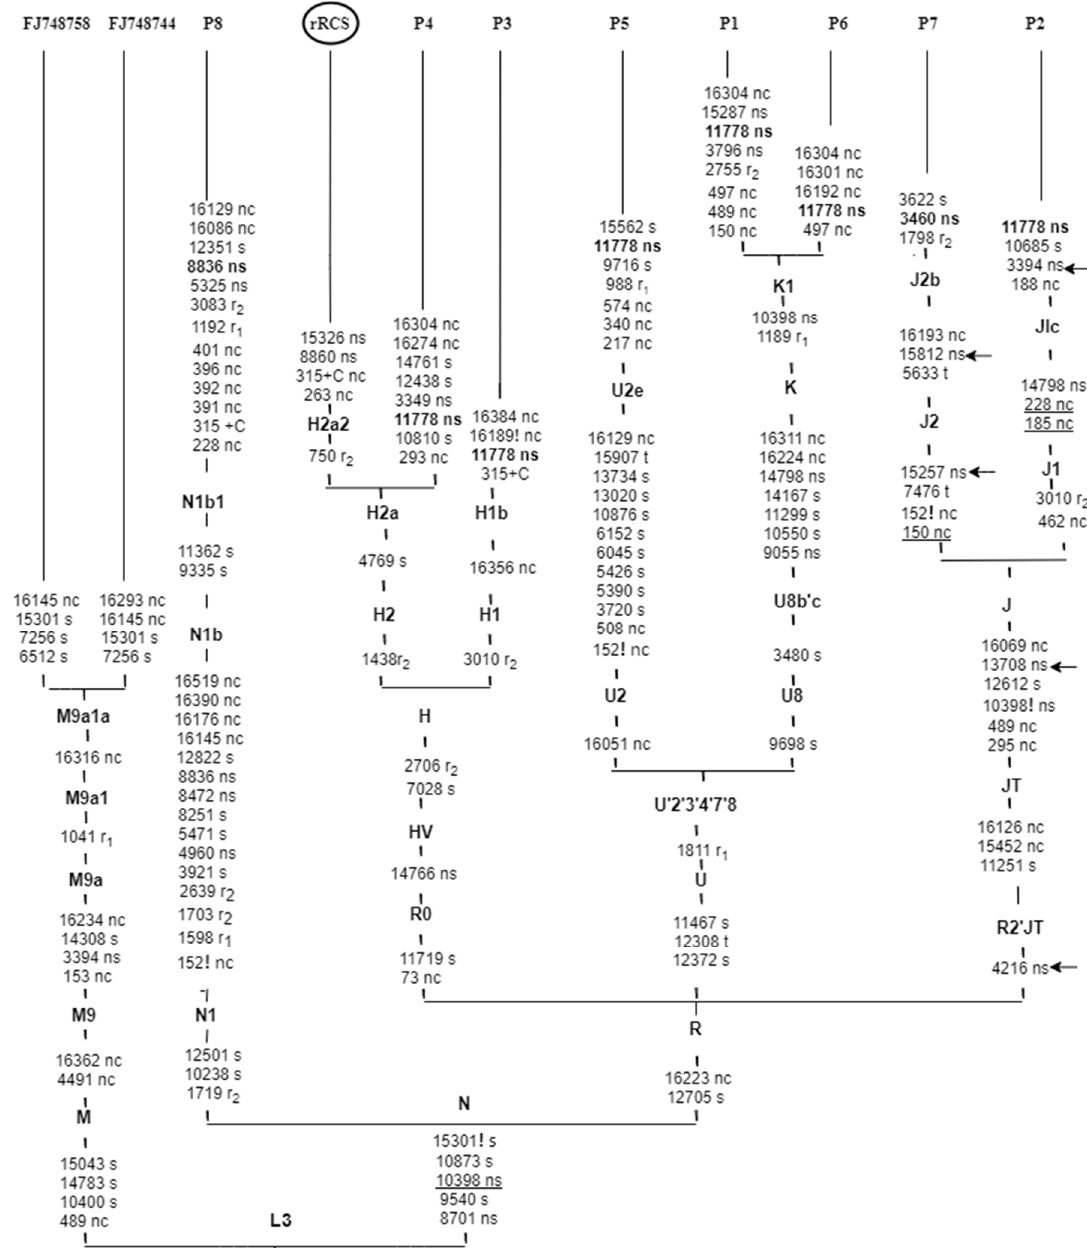
Figure 2. Schematic phylogenetic tree encompassing the complete mtDNA genome from eight Serbian probands with pathogenic LHON mutations. The tree was rooted by following the nomenclature of mtDNA tree Build 17, using the reference sequence rCRS haplogroup (H2a2a). Underlining indicates recurrent mutations; su ffi xes indicate back mutations (!), non-coding region (nc), synonymous variants (s), nonsynonymous variants (ns). Variations in the transfer RNA and the ribosomal RNA1, and 2 genes are denoted by (t), (r 1 ), and (r 2 ), respectively. Previous mtDNA sequences that have showed the association of m.3394 variant on haplogroup M9a background in Chinese families, are added (GenBank accession number FJ748744 and FJ748758, [49]). The arrows indicate the nonsynonymous mutations that might have a potential role in LHON expression. LHON primary mutations are shown in bold and were added to the tree after phylogeny tree construction.